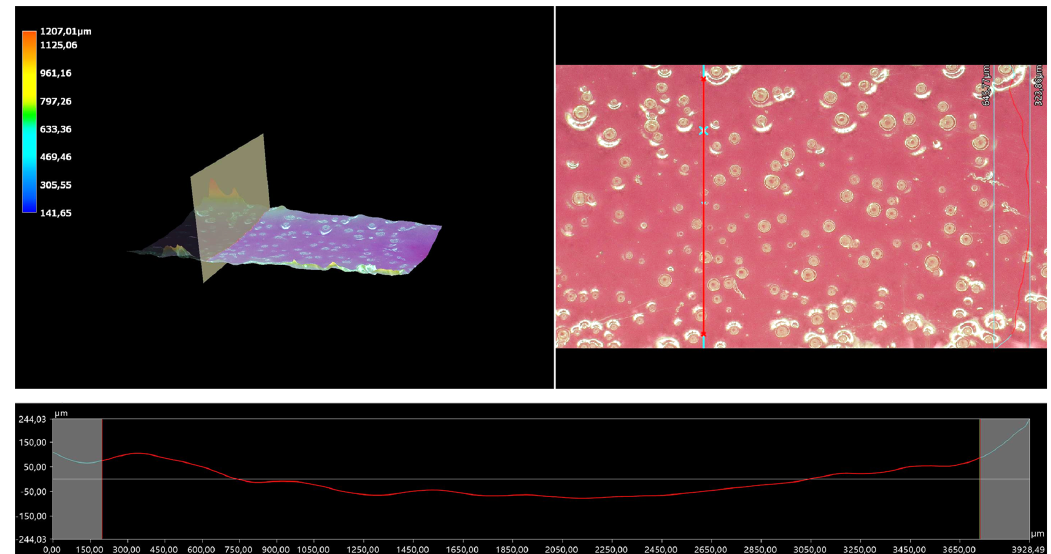
Figure 11. A 3D view of the roughness profile of sample 0.075/Photo.